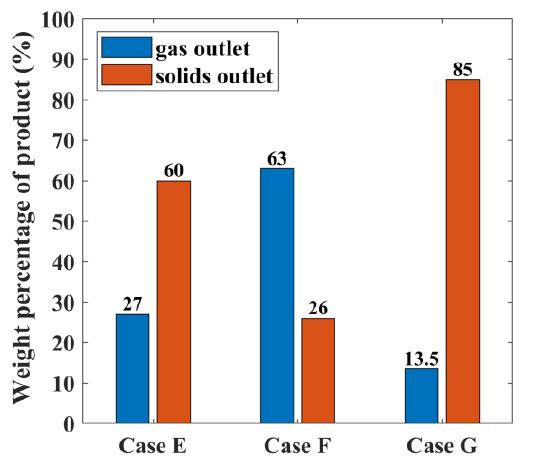
Figure 13. Comparison of weight percentage (%) of product recovered at the outlets for cases E –